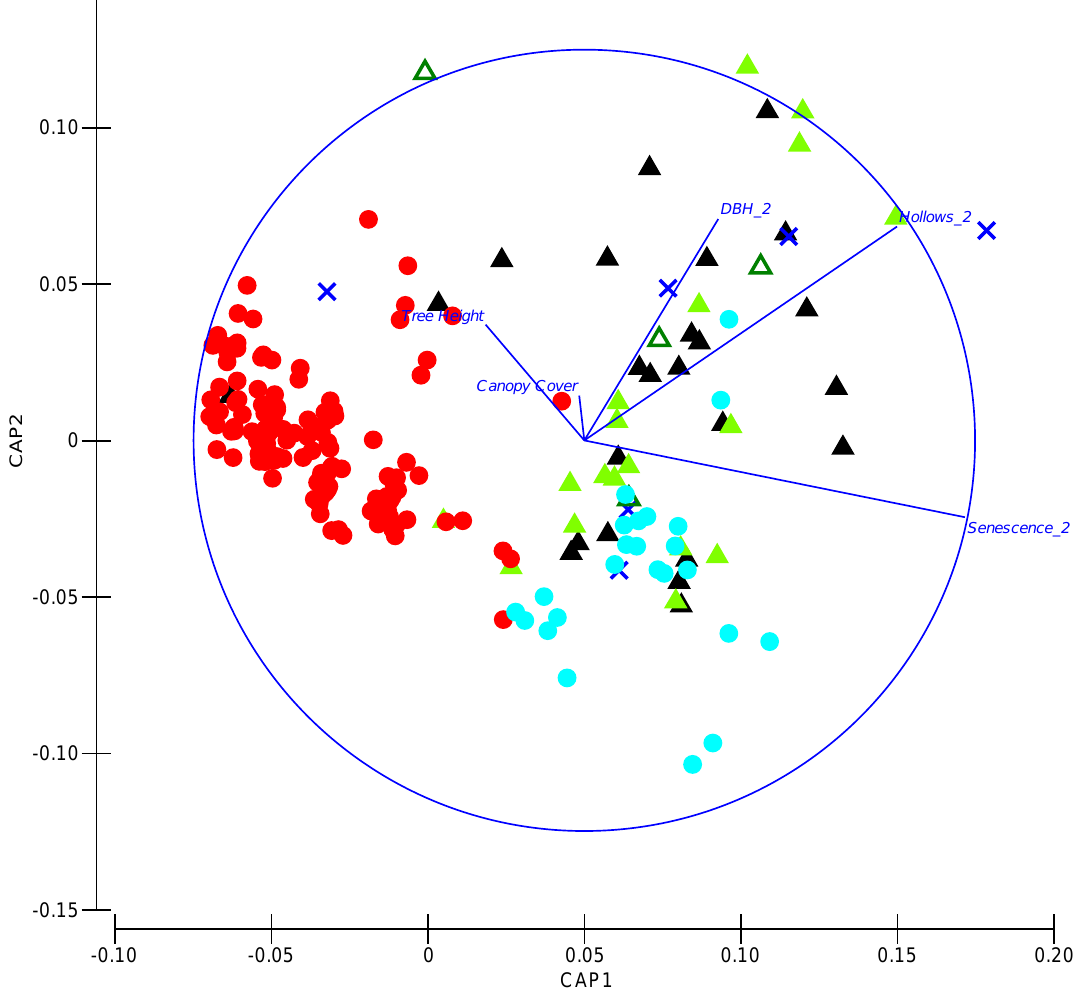
Figure 4. Canonical analysis of principal (CAP) coordinates illustrating characteristics of trees used for roosting and local available trees. Solid red and cyan circles indicate living and dead available trees, respectively. Blue crosses indicate trees used for roosting by V. vulturnus . Solid light green, open dark green and solid black triangles indicate trees used for roosting by N. corbeni , N. geoffroyi and N. gouldi , respectively.